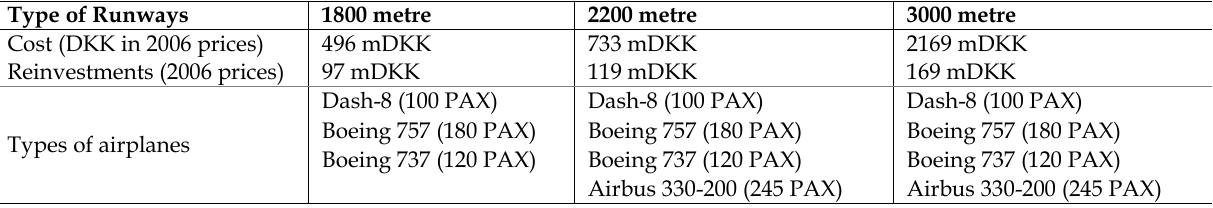
Table 2. Alternative runway lengths, costs and possible aeroplanes Type of Runways 1800 metre 2200 metre 3000 metre Cost (DKK in 2006 prices) 496 mDKK 733 mDKK 2169 mDKK Reinvestments (2006 prices) 97